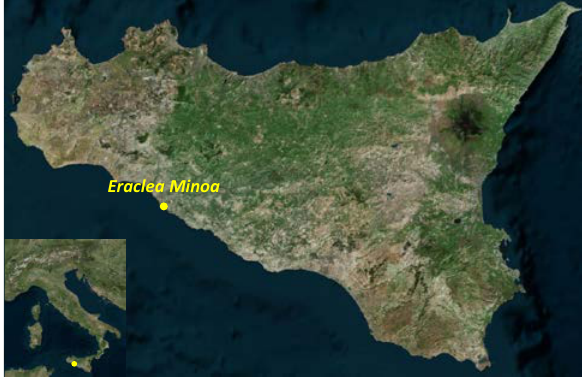
Figure 1. Position of Eraclea Minoa archaeological site.